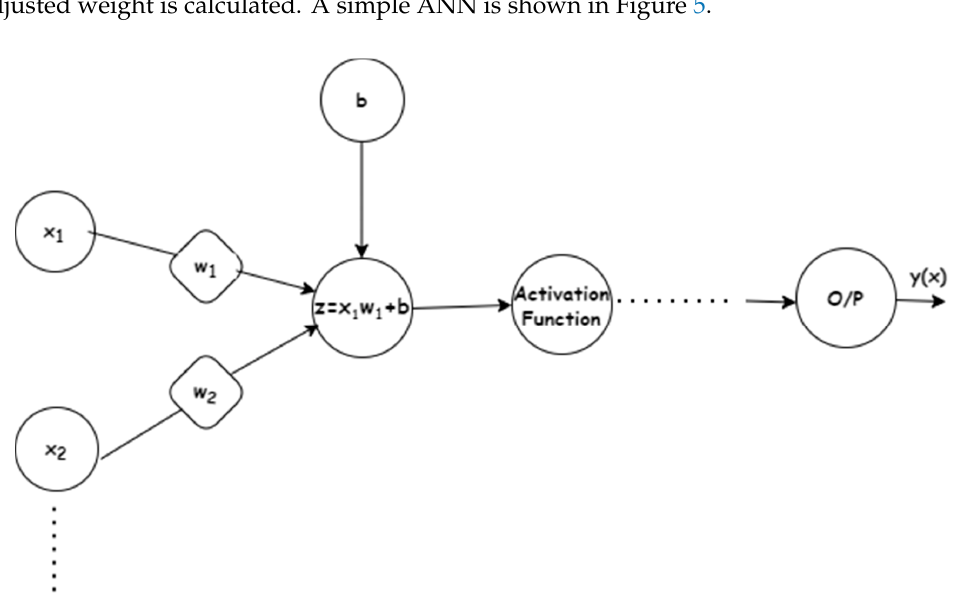
Figure 5. A simple Artificial Neural Networks (ANN).